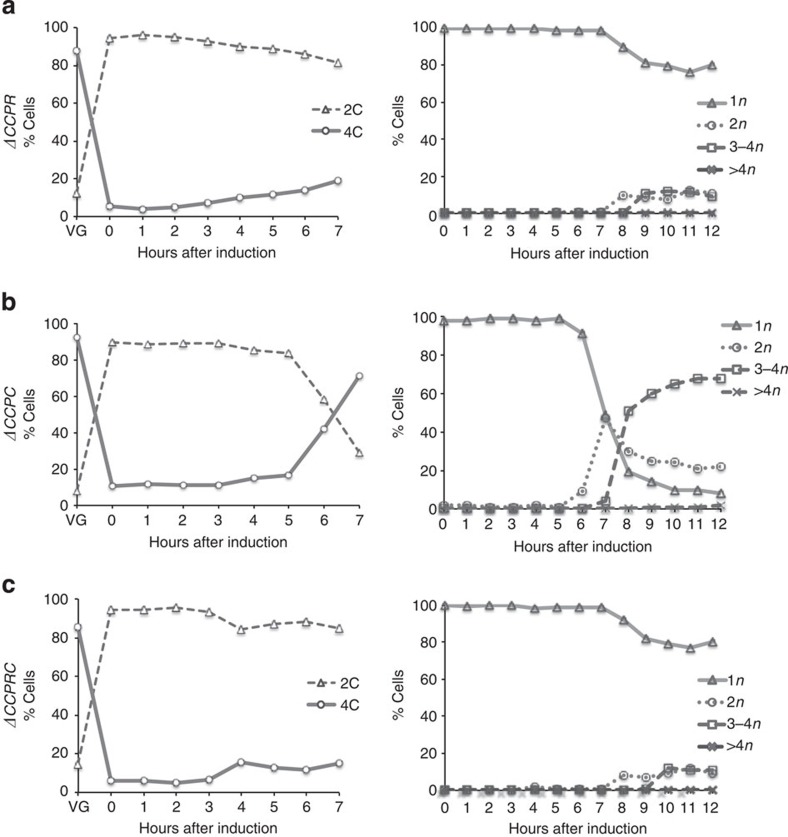
Mitotic- and meiotic-specific cyclins are additively required for meiotic cell cycle progression.(a) Δcig2Δcig1Δpuc1Δrem1 (ΔCCPR, Pi240), (b) Δcig2Δcig1Δpuc1Δcrs1 (ΔCCPC, Pi296) and (c) Δcig2Δcig1Δpuc1Δrem1Δcrs1 (ΔCCPRC, Pi278), strains were treated as in Figs 2 and 4a to induce synchronous meiosis. DNA (left panels) and nuclei number per cell (right panels) were followed every hour after meiosis induction.